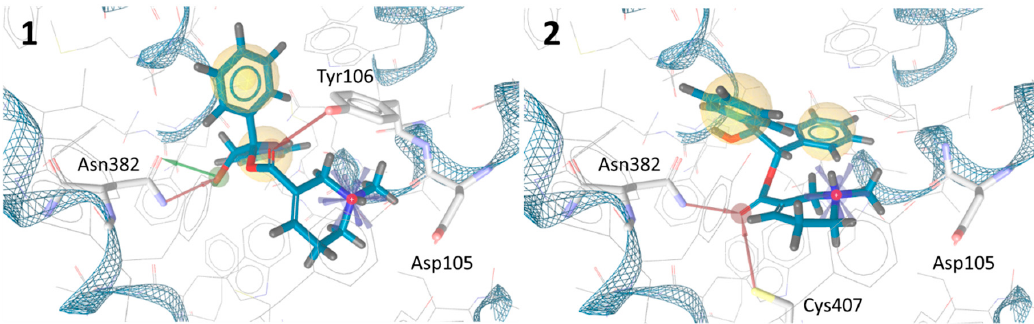
Figure 4. Calculated binding poses of protonated 1 and 2 in the orthosteric binding pocket of human muscarinic acetylcholine receptors (mAChR) M1. Amino acid residues participating in non-hydrophobic interactions are highlighted. 1 shows hydrophobic interactions to Val113, Trp157, Leu183, Ala193, Ala196, Trp378 and 2 to Tyr106, Trp157, Ala193, Ala196, Trp378, Tyr381, and Val385 (not highlighted).